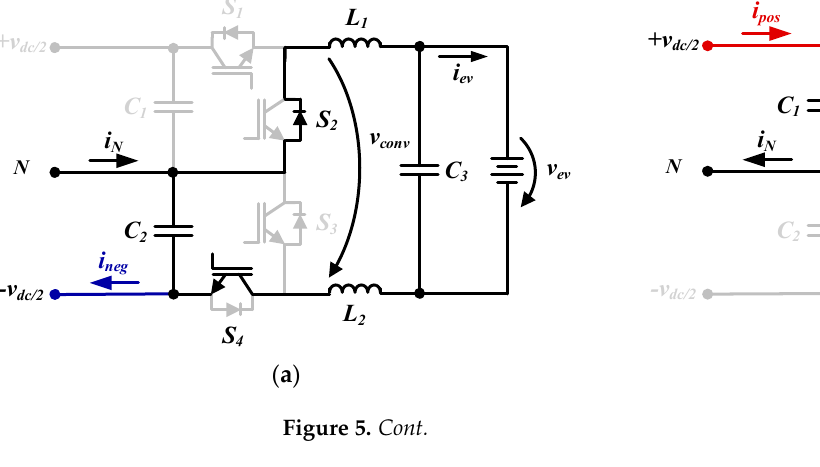
Figure 5. Operation principle of the multilevel dc–dc converter under fault conditions connected to a bipolar dc grid: ( a ) failure in the positive wire of the bipolar dc grid; ( b ) failure in the negative wire of the bipolar dc grid; ( c ) failure in the neutral wire of the bipolar dc grid; ( d ) common operation mode to the mentioned three failures. 2.3. Operation Principle of the Control Strategy Applied in Normal and Fault Conditions This section presents the operation principle of the proposed control strategy used for EV battery charging, which was applied in two different situations: normal and fault conditions. Equation (1) is the equation that determines the output voltage of the dc–dc power converter, which corresponds to the voltage that the converter must produce in order to obtain the desired current for charging the EV battery: v conv = v L 1 + v ev + v L 2